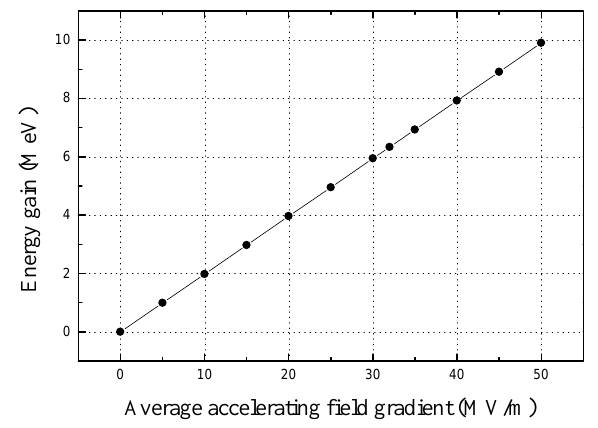
FIG. 9. Energy gain vs accelerating field in the 4-cell, PWT linac structure.